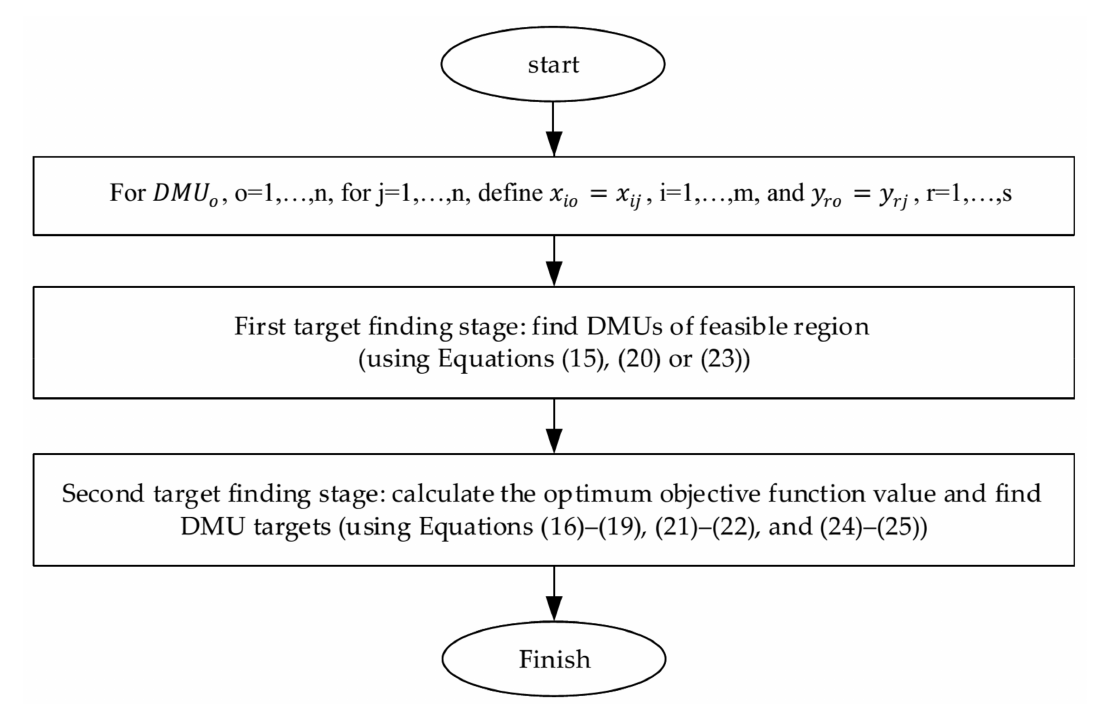
Figure 2. Extended RBA for finding non-radial FDH models targets of the interactive